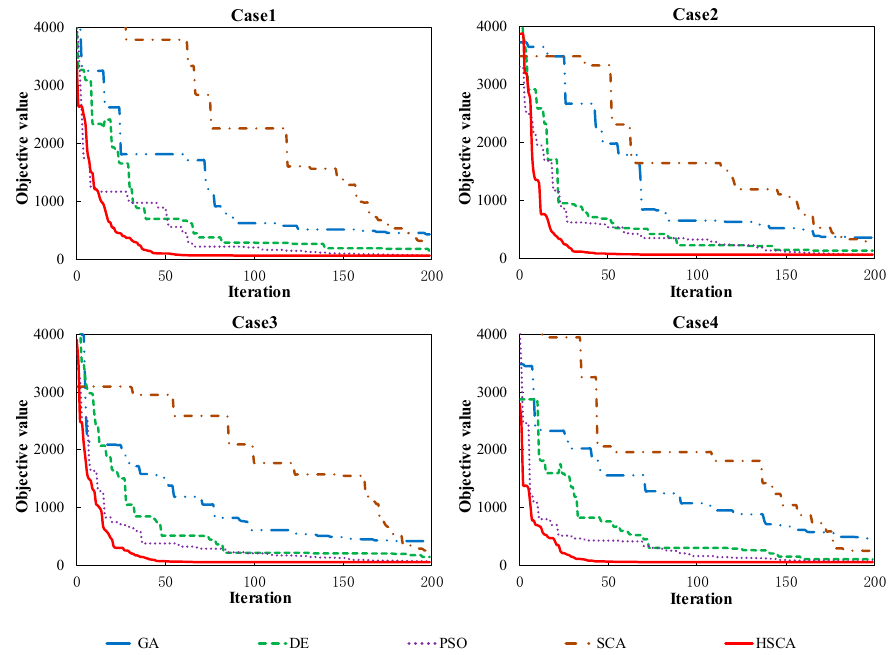
Figure 8. Convergence trajectories of four methods for the mature hydropower system in four cases.